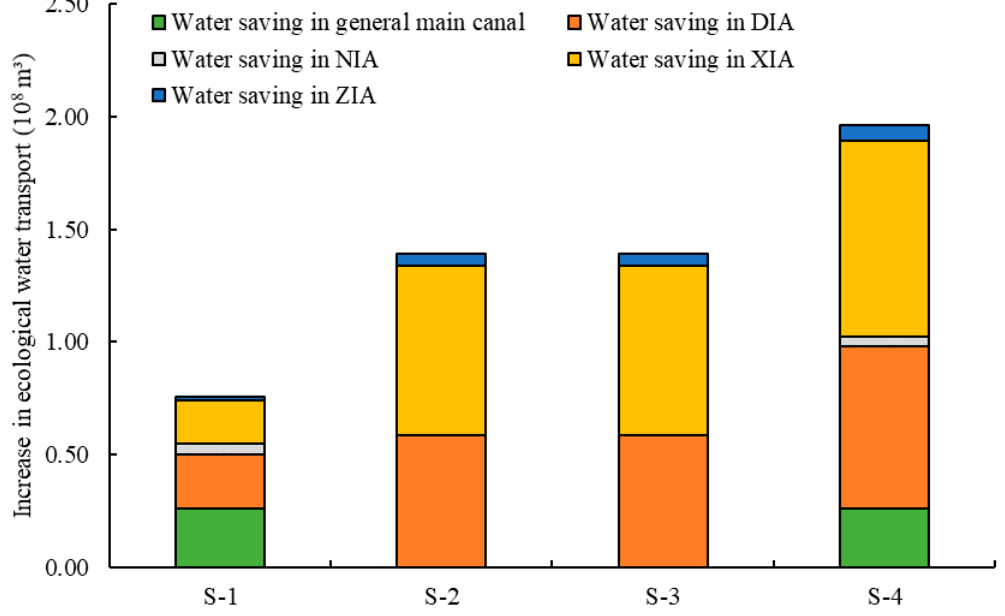
Figure 8. Increase of ecological water transfer in four typical scaled water-saving irrigation scenarios.